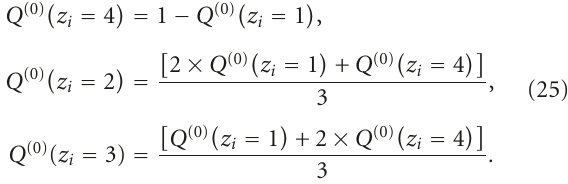
bottom targets according to the baseline. Due to the above reasons, the overall improvement of the proposed method is not always significant as compared with other methods, al- though the proposed method performs more steadily than baseline method on di ff erent